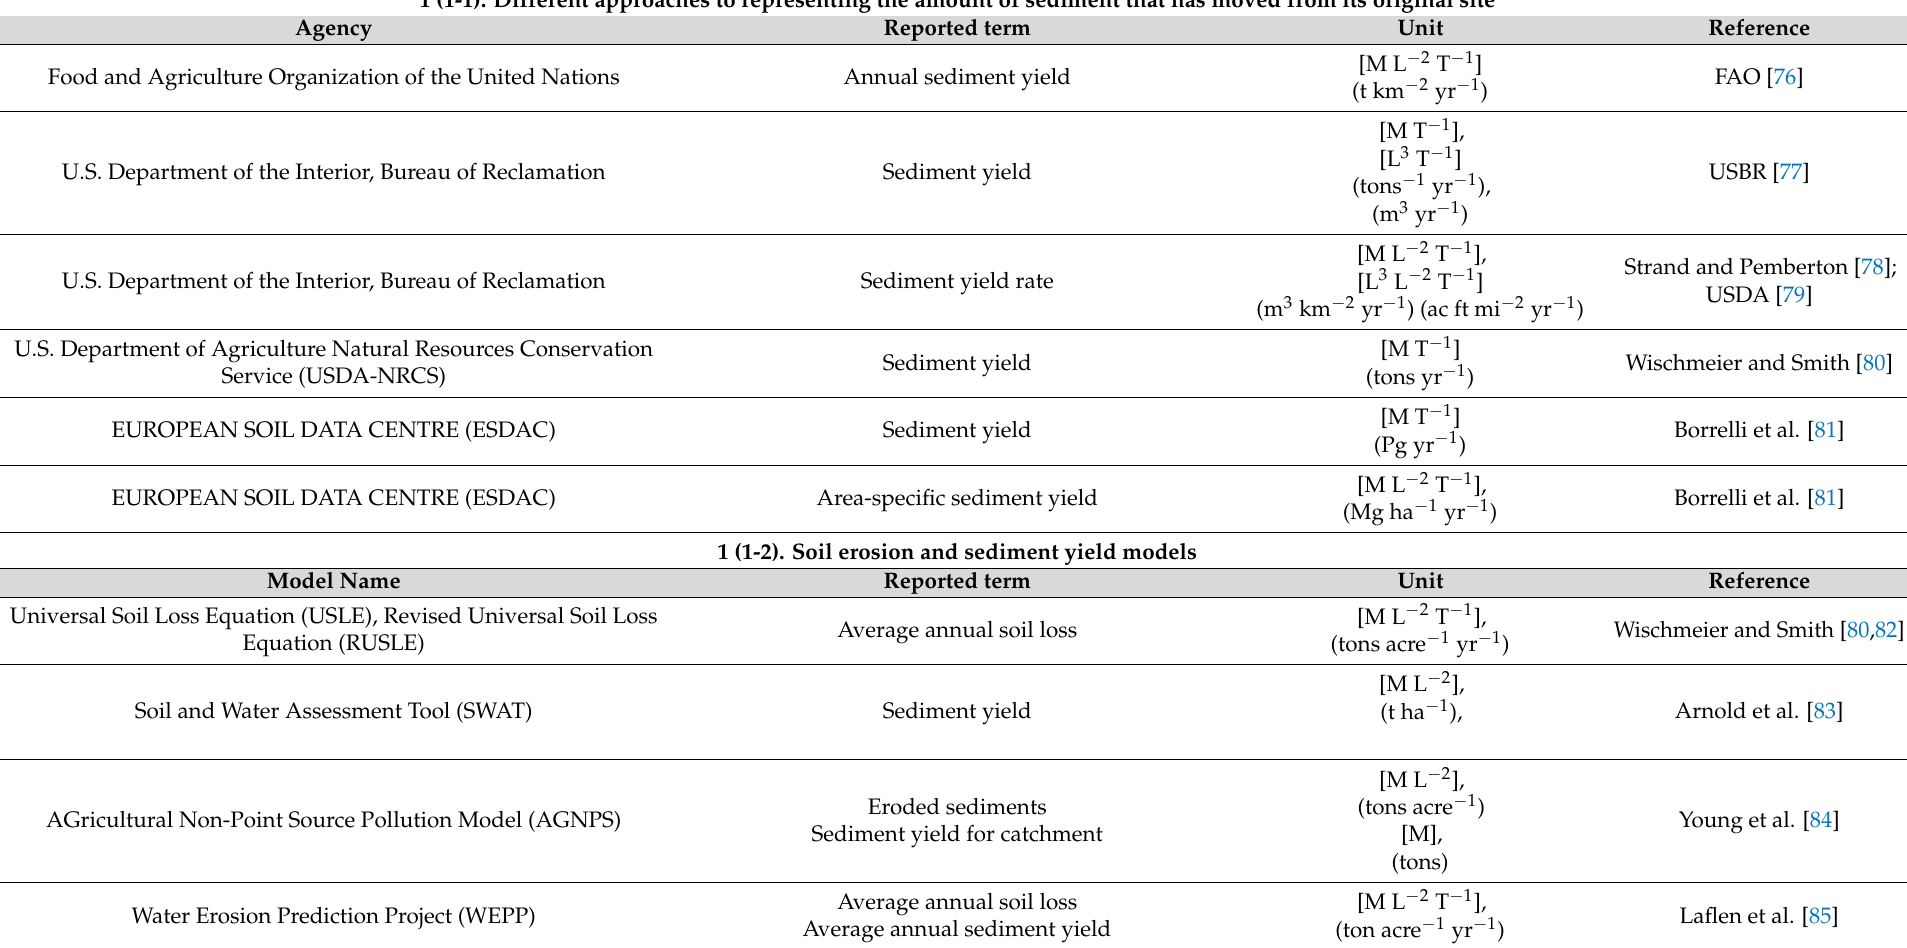
Table 1. Different approaches to reporting sediment